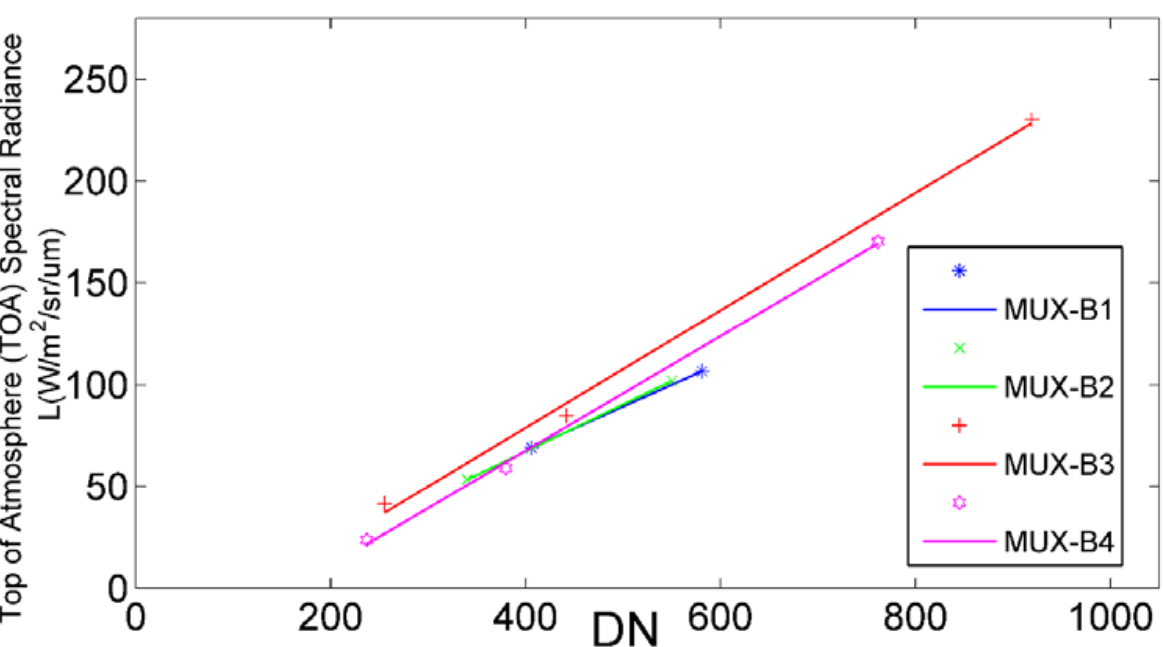
Figure 9. Calibration result of the gray-scale permanent artificial targets (coefficient A).